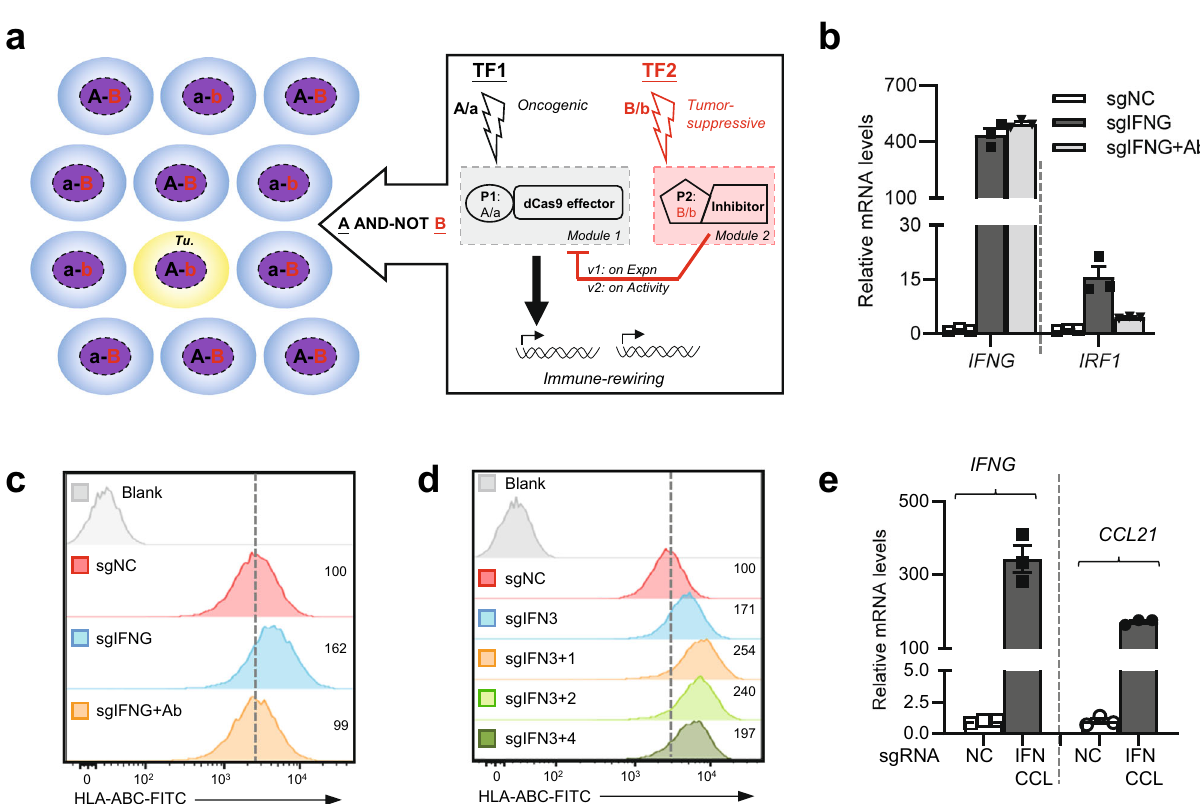
Fig. 1 An active CRISPRa can fl exibly program immunostimulatory outputs in tumor cells. a The overall design for our tumor-targeting synthetic circuit is illustrated. Different cells on the left can be de fi ned by the combinatorial status regarding two TFs (A/a and B/b, in black and red). The upper- and lower- case letters respectively indicate their high and low levels. A tumor cell ( Tu .) selectively featuring simultaneous activation of TF1 and inactivation of TF2 ( “ A-b ” ) is depicted in yellow. On the right, a synthetic circuit is to specify functional output in the “ A-b ” tumor cells. Promoters (P1 and P2) are used as sensors for TF1 and TF2, respectively. The circuit adopts CRISPR/dCas9 transcriptional effectors for input processing and actuation. Here, two sequential versions of the circuit are denoted (v1 and v2). They respectively feature a TF2-sensing inhibitory module (pink) against either the expression (v1) or activity (v2) of the dCas9 effector in the activation module (grey). b , c H1299 cells were transfected with dCas9 (under the survivin promoter), MPH, and a high-performance activating sgRNA against IFNG (sgIFNG or a negative control sgNC). Cells were incubated for 48 h in the presence of 10 μ g/ml of IgG or anti-IFN γ (Ab) and were then harvested for qPCR ( b ) or fl ow cytometry analyses ( c ). d H1299 cells were transfected similarly as above for 48 h. Combinations of sgRNAs targeting sequences upstream of IFNG (all containing a well-performing sgRNA, i.e., sgIFN3) were included in the plasmid mix. In both ( c ) and ( d ), the dotted lines denote the levels in control cells. Additionally, the relative median fluorescence intensity [MFI] values are marked. e The H1299 cells were transfected similarly as in ( d ), except that sgRNAs against IFNG and CCL21 were introduced for multiplexed activation. Cells were harvested 24 h after transfection for qPCR analyses. In this fi gure, the qPCR results are presented as mean ± SEM ( n = 3 biological replicates). Source data are provided in the Source Data fi